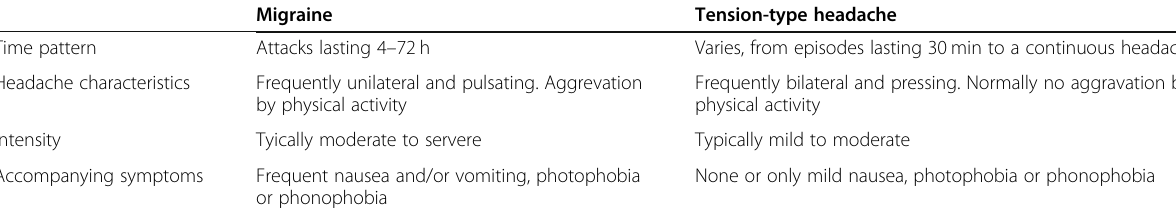
Table 5 Characteristics to distinguish between migraine and tension-type headache